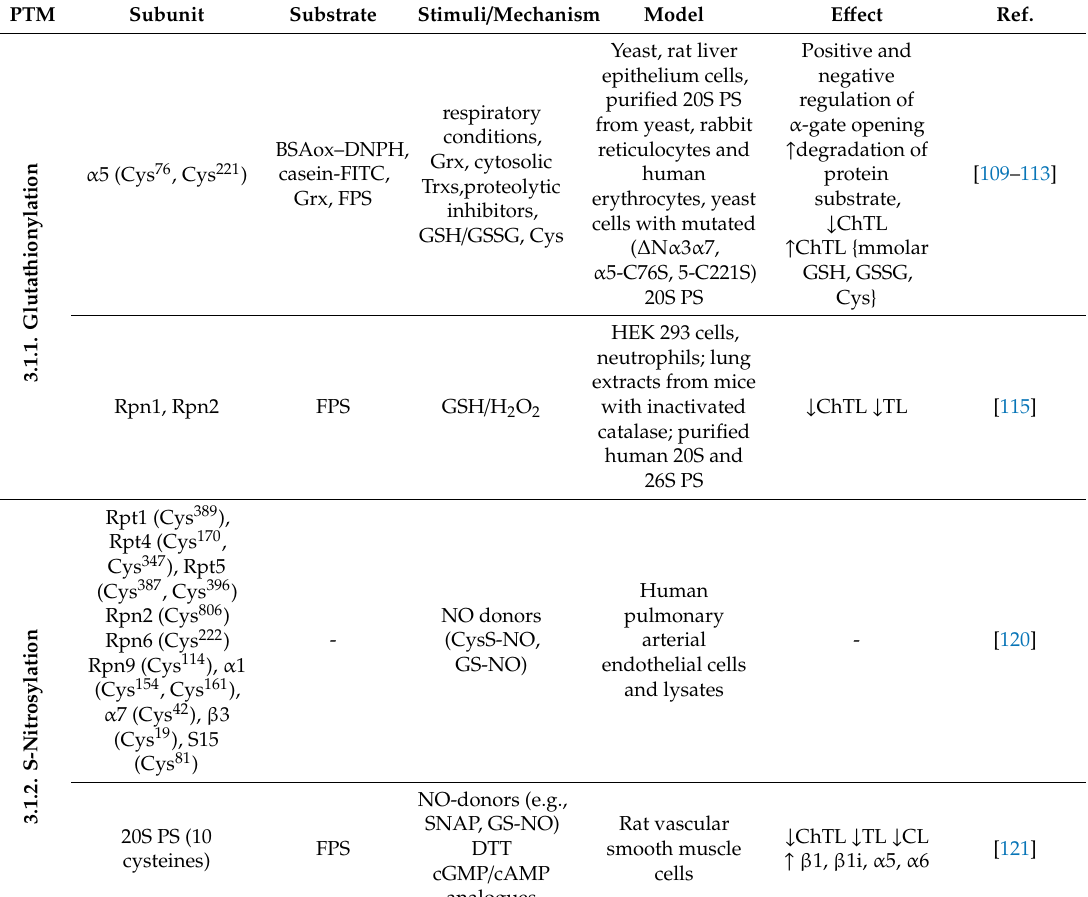
Table 2. ( a ) Posttranslational modifications of proteasome: S-modifications and poly-ADP ribosylation; ( b ) Posttranslational modifications of proteasome: Phosphorylation; ( c ) Posttranslational modifications of proteasome: Phosphorylation (continued) and O-GlcNAcylation; ( d ) Posttranslational modifications of proteasome: N-acetylation and ubiquitination; ( e ) Posttranslational modifications of proteasome: N-SUMOylation, N-myristoylation and N-methylation. ( a ) Subunit Substrate Stimuli / Mechanism Model E ff ect